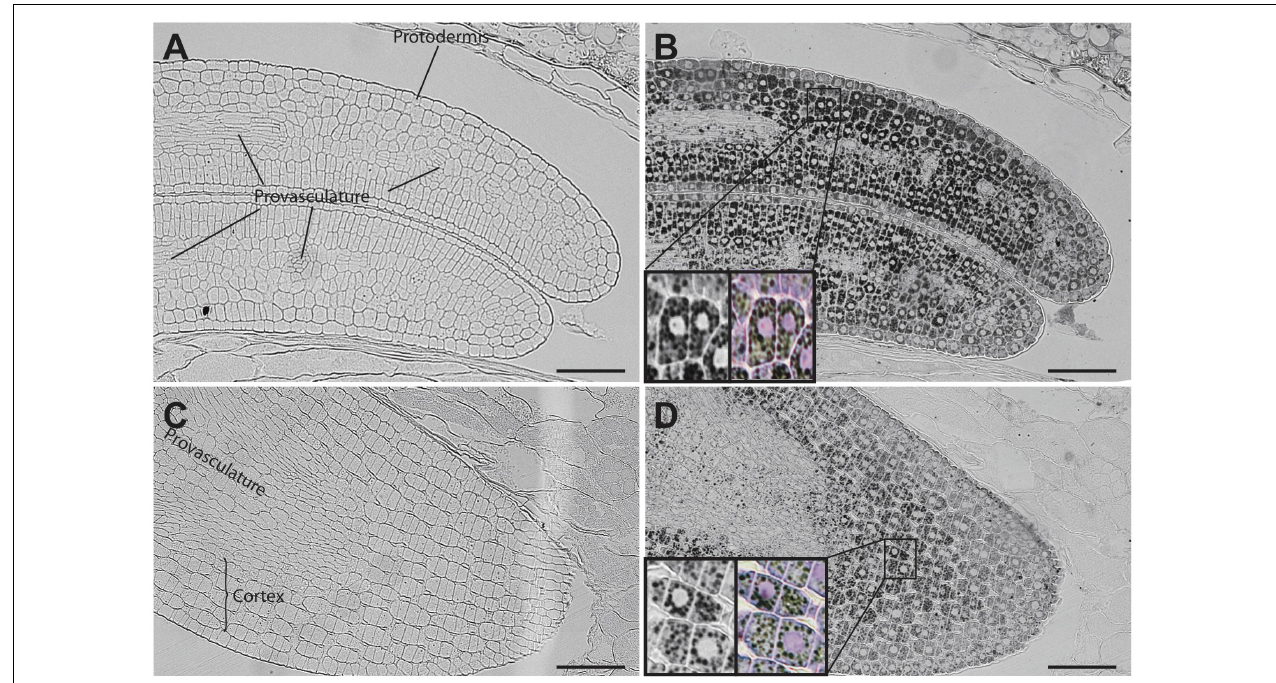
FIGURE 6 | Iron distribution in C. quinoa seeds at mature embryo stage. C. quinoa seeds at the mature embryo stage, before seed desiccation stage (21 days postanthesis), were collected from fruits, embedded in Technovit resin and sectioned (3 µ m). The sections were then stained with Perls/DAB (B , D) . Cotyledons and hypocotyl are shown in A , B and C , D , respectively. The zoom in B and D show iron accumulation in cell structures different from nuclei. Perls/DAB and Toluidine blue were used in order to reveal different cell structures. Unstained sections were used as control (A , C) . The scale bar represents 100 µ m.